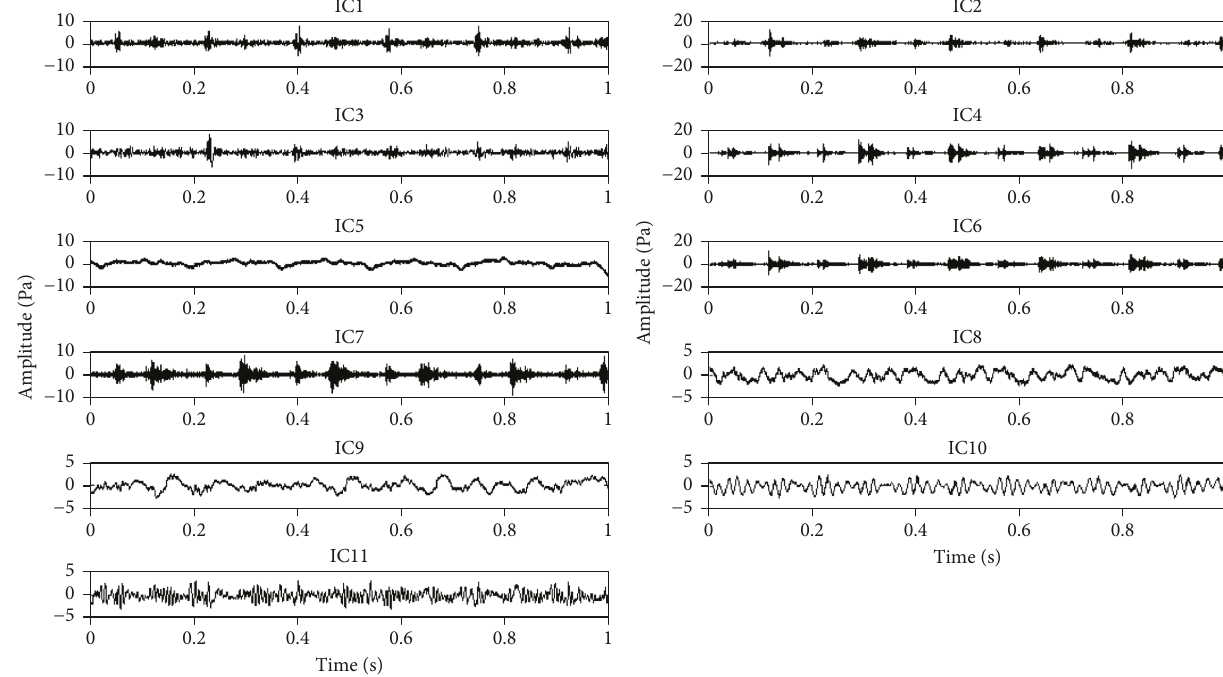
Figure 17: EEMD-RobustICA separation